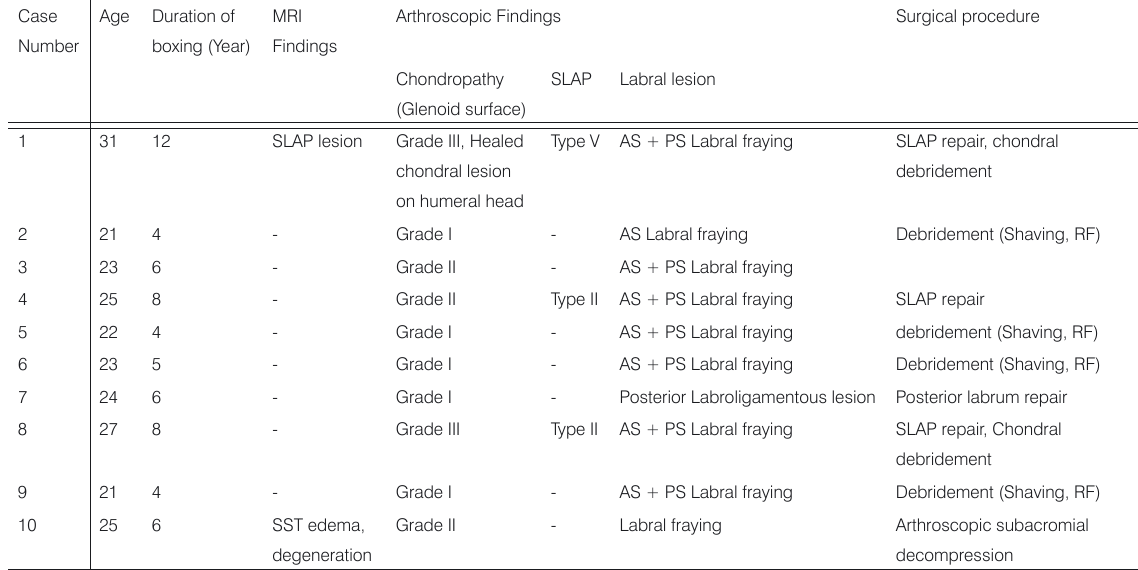
Table 1. Patients demographics and arthroscopic